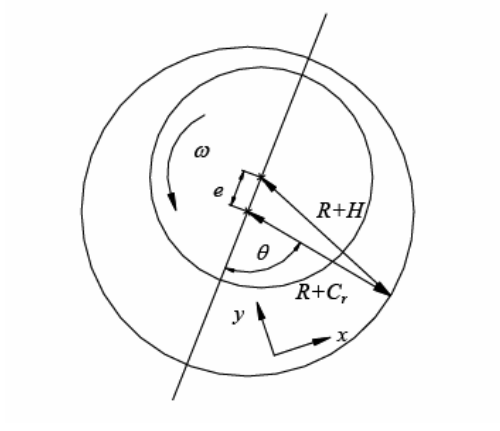
Fig. 2. Plain journal bearing